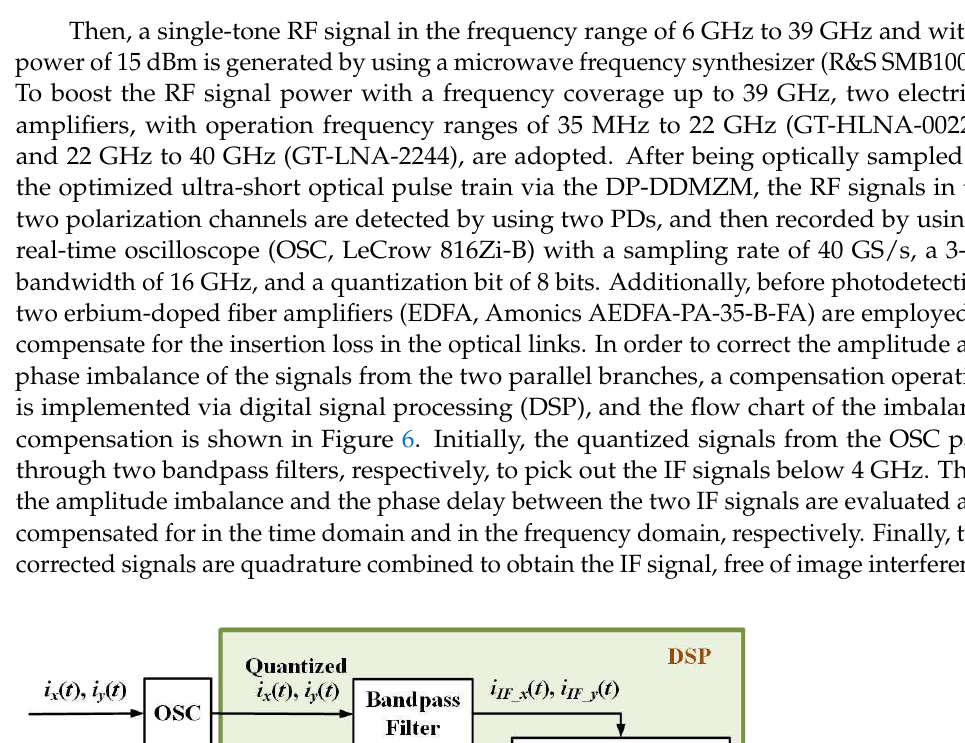
Figure 5. Optical spectrum of the ultra-short optical pulse train under a modulation index of 0.7π and a bias phase shift of 0.7π.